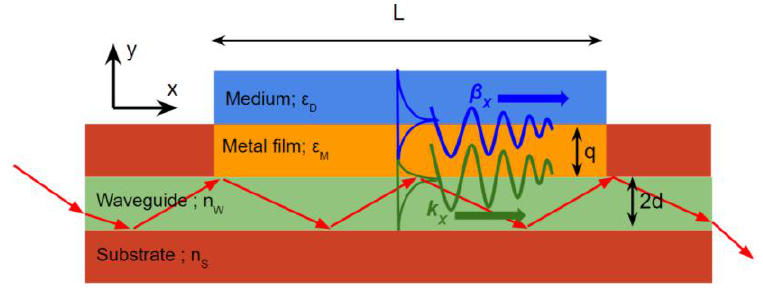
Figure 5. SPR coupling using waveguide structure. TIR of TM waves the waveguide layer excites SP in the metal film region L.